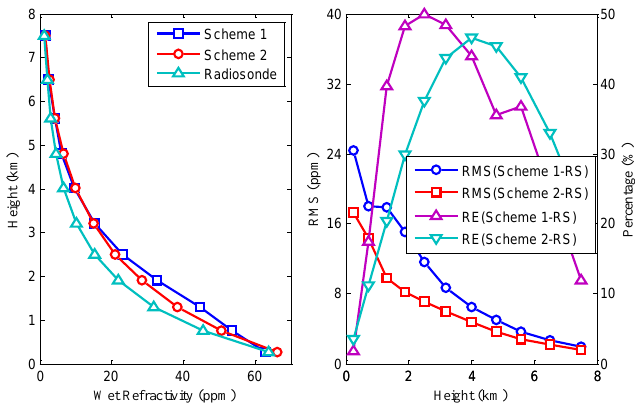
Figure 9. Wet refractivity profiles derived from two schemes and radiosonde (left), as well as the RMS and relative error (RE) of their differences (right) at various altitudes over the period of Doy 303 to 317, 2015.